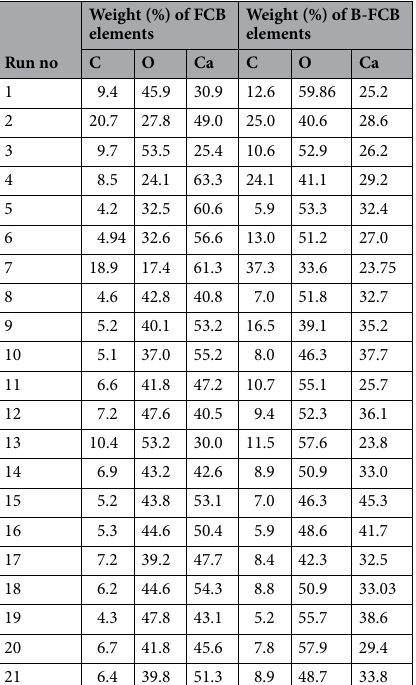
Table 4. The chemical weight (%) of chemical elements C, O, and Ca in FCB and